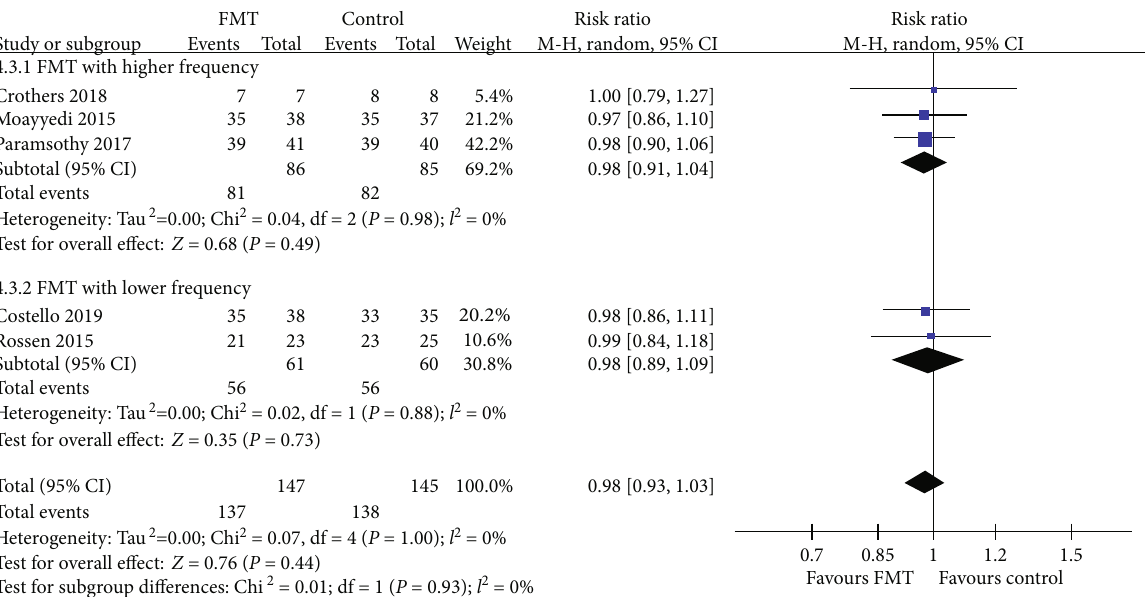
Heterogeneity: Tau 2 =0.00; Chi 2 = 0.02, df = 1 ( P = 0.88); l 2 = 0% Test for overall effect: Z = 0.35 ( P =